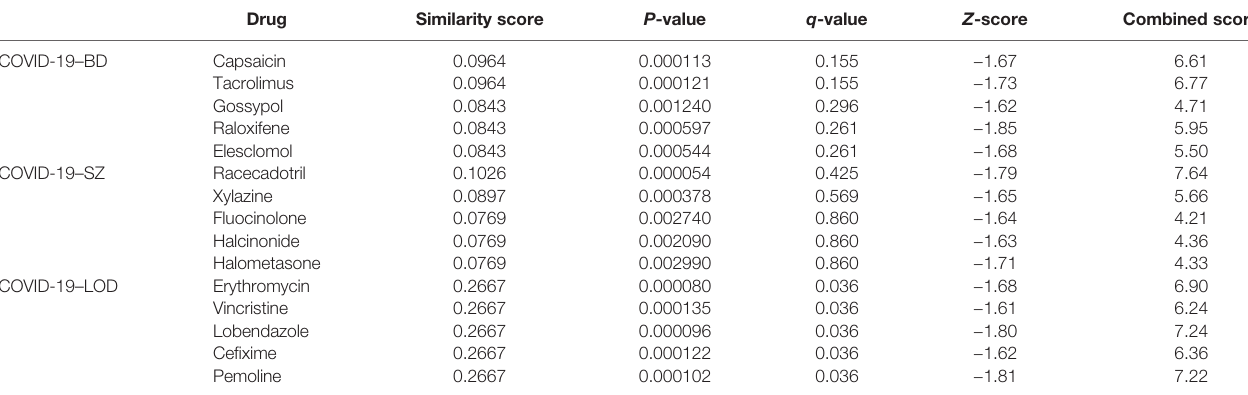
TABLE 2 | Top 5 drugs predicted for use in COVID-19 with BD, SZ, or LOD.